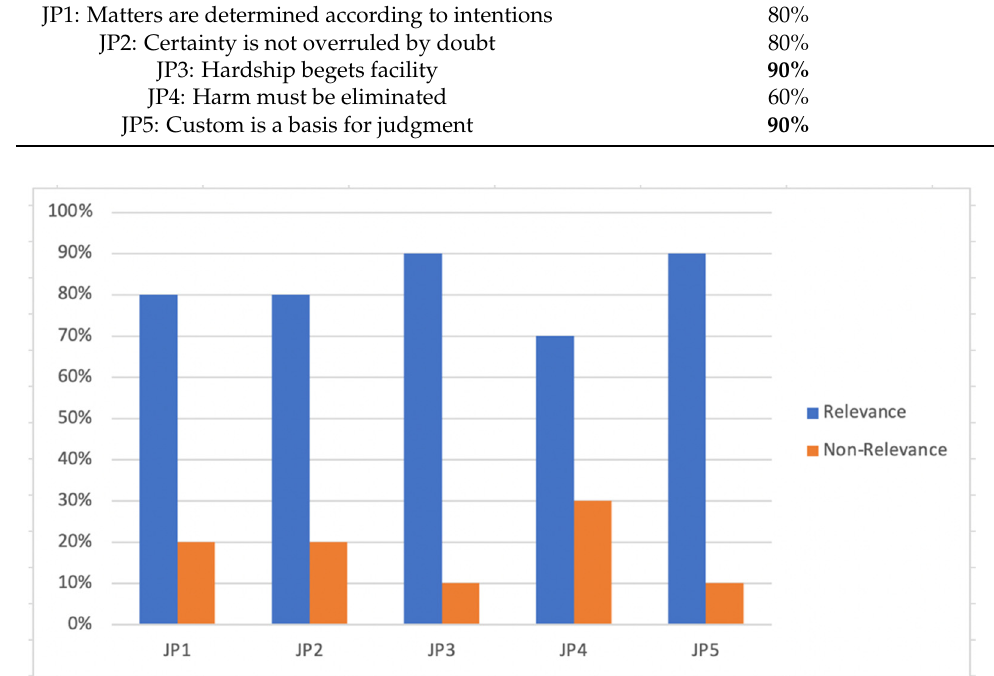
Table 3. Relevance of results returned for each of the five principles (bold shows best values). Principle